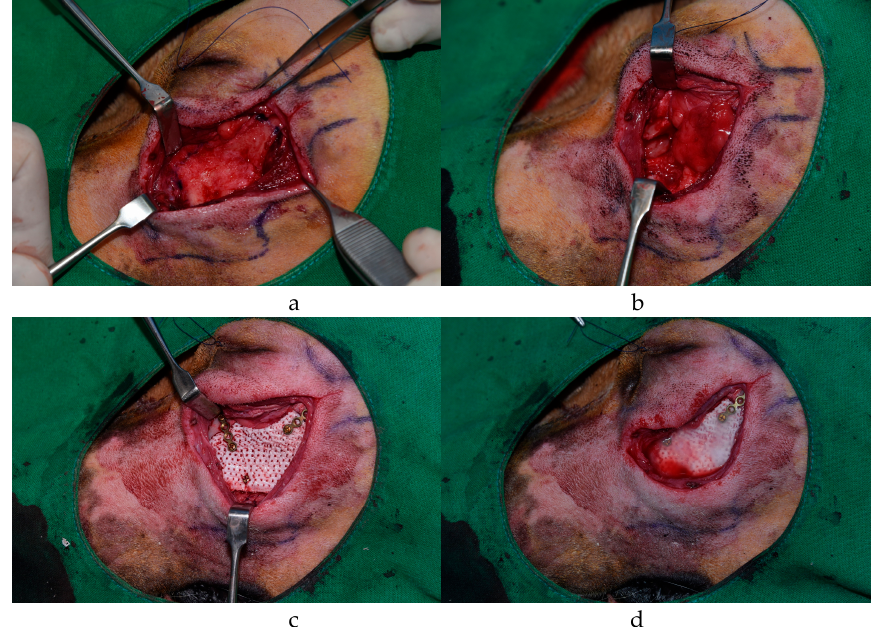
Figure 1. Experimental design: ( a ) exposed maxillary bone in a beagle model; ( b ) the defect was made; ( c ) the polycaprolactone/tricalcium phosphate (PCL/TCP) scaffold was fixed by plate and screw; and ( d ) fibrin glue seeding after adipose-derived stem cells (ADSCs) or bone marrow stem cells (BMSCs) were applied.